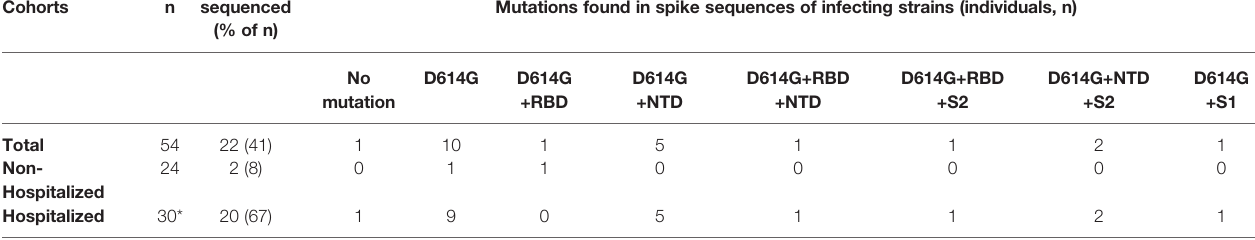
TABLE 2 | Location of spike mutations identi fi ed in a subset of samples from infected individuals. Cohorts n sequenced (% of